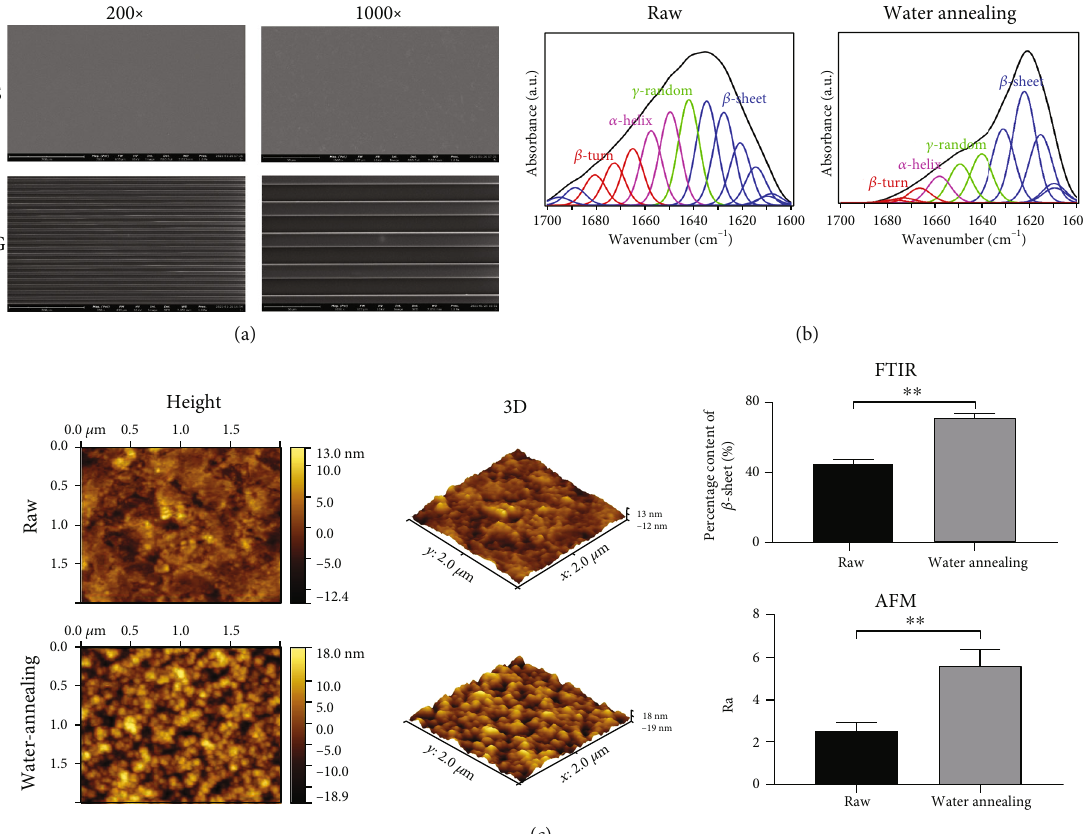
Figure 2: SEM, FTIR, and AFM characterization of SF fi lms. (a) SEM. Group S: SF fi lms without micropatterns; Group G: SF fi lm with micropatterns. The surface of SF fi lm material was clear and stable. (b) FTIR. The β -sheet content in micropattern SF fi lm after water annealing was signi fi cantly increased. (c) AFM. The nanoscale roughness on the surface of the micropattern SF fi lm after water annealing treatment was signi fi cantly